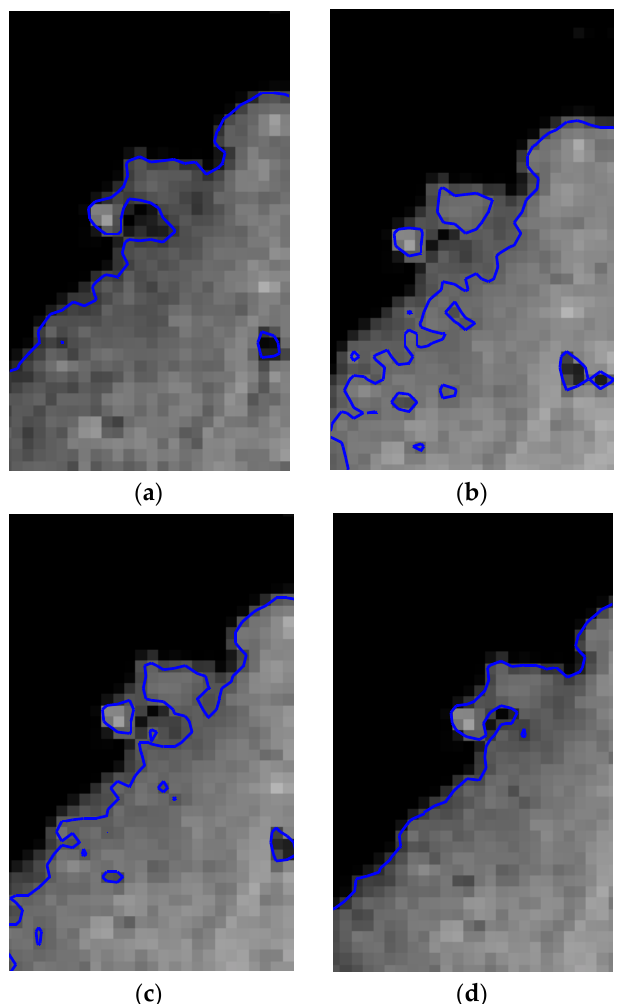
Figure 7. Local shoreline extraction results: ( a ) Improved Canny operator method; ( b ) Boundary- tracking algorithm; ( c ) Traditional geometric active-contour modeling method; ( d ) Proposed